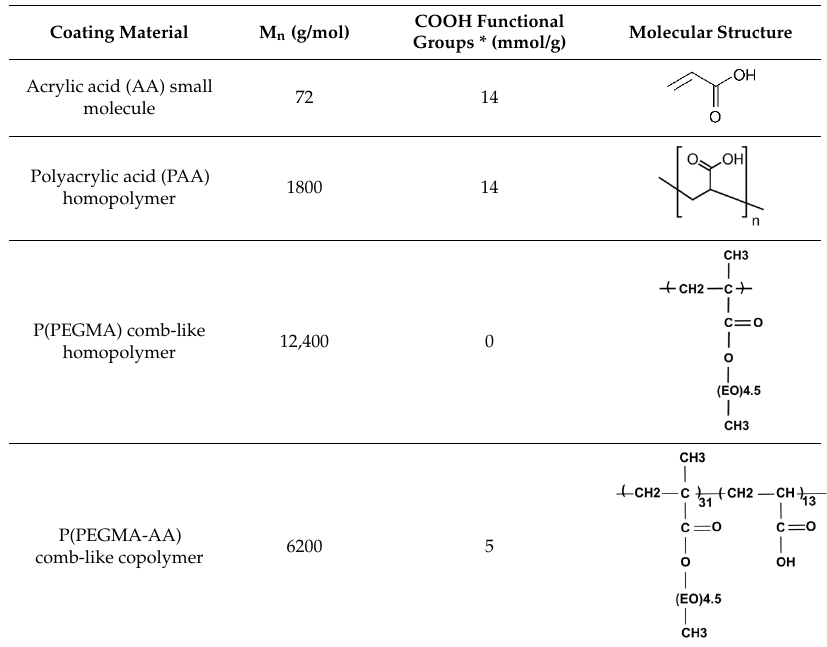
Table 1. Characteristics of compounds used for coating magnetite nanoparticles (MNPs).